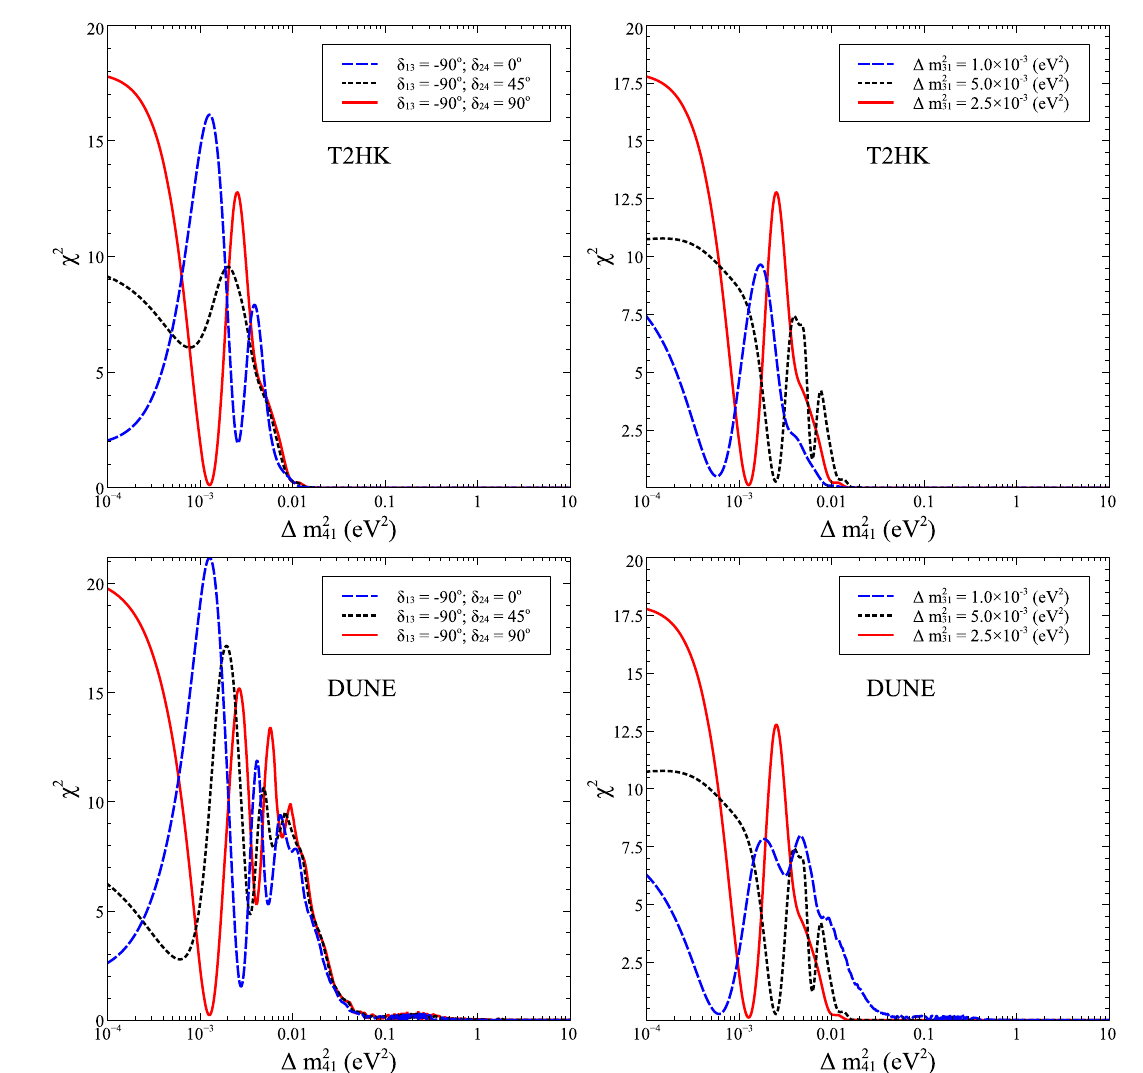
Fig. 2 χ 2 as a function of (cid:2) m 2 for different combinations of CP-violating phases (left panels) and various values of (cid:2) m 2 41 panels are for T2HK while bottom panels are for DUNE